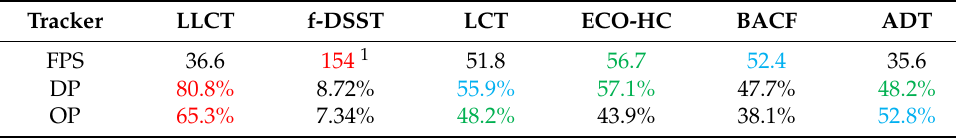
Table 4. The quantitative performance of the field experiment. Tracker